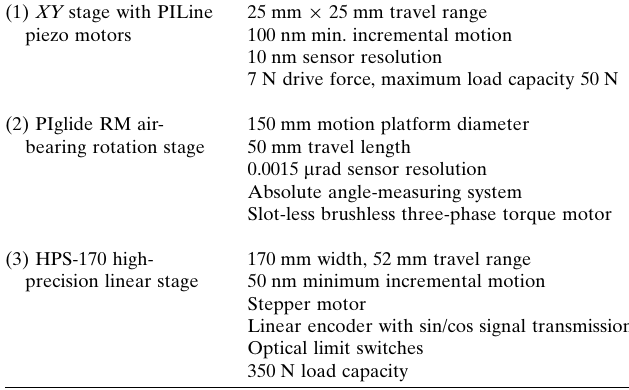
Table 1 Factory characteristics of the new positioning parts used for the sub- micrometer setup on the Extreme Conditions Beamline (ECB).